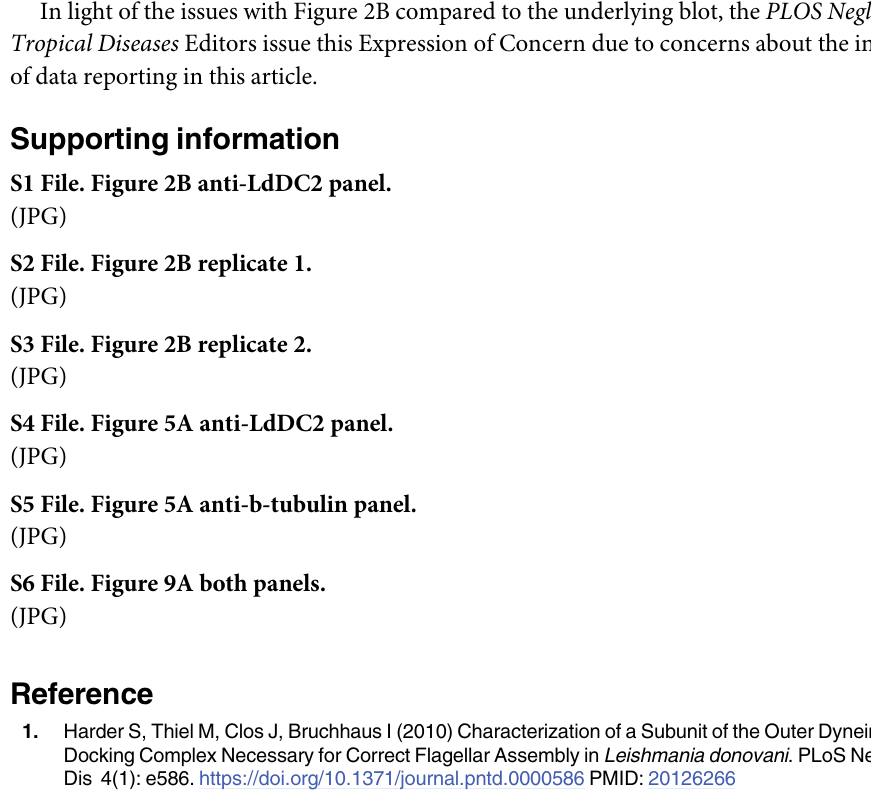
S1 File. Figure 2B anti-LdDC2 panel. S2 File. Figure 2B replicate 1. S3 File. Figure 2B replicate 2. S4 File. Figure 5A anti-LdDC2 panel. S5 File. Figure 5A anti-b-tubulin panel. S6 File. Figure 9A both